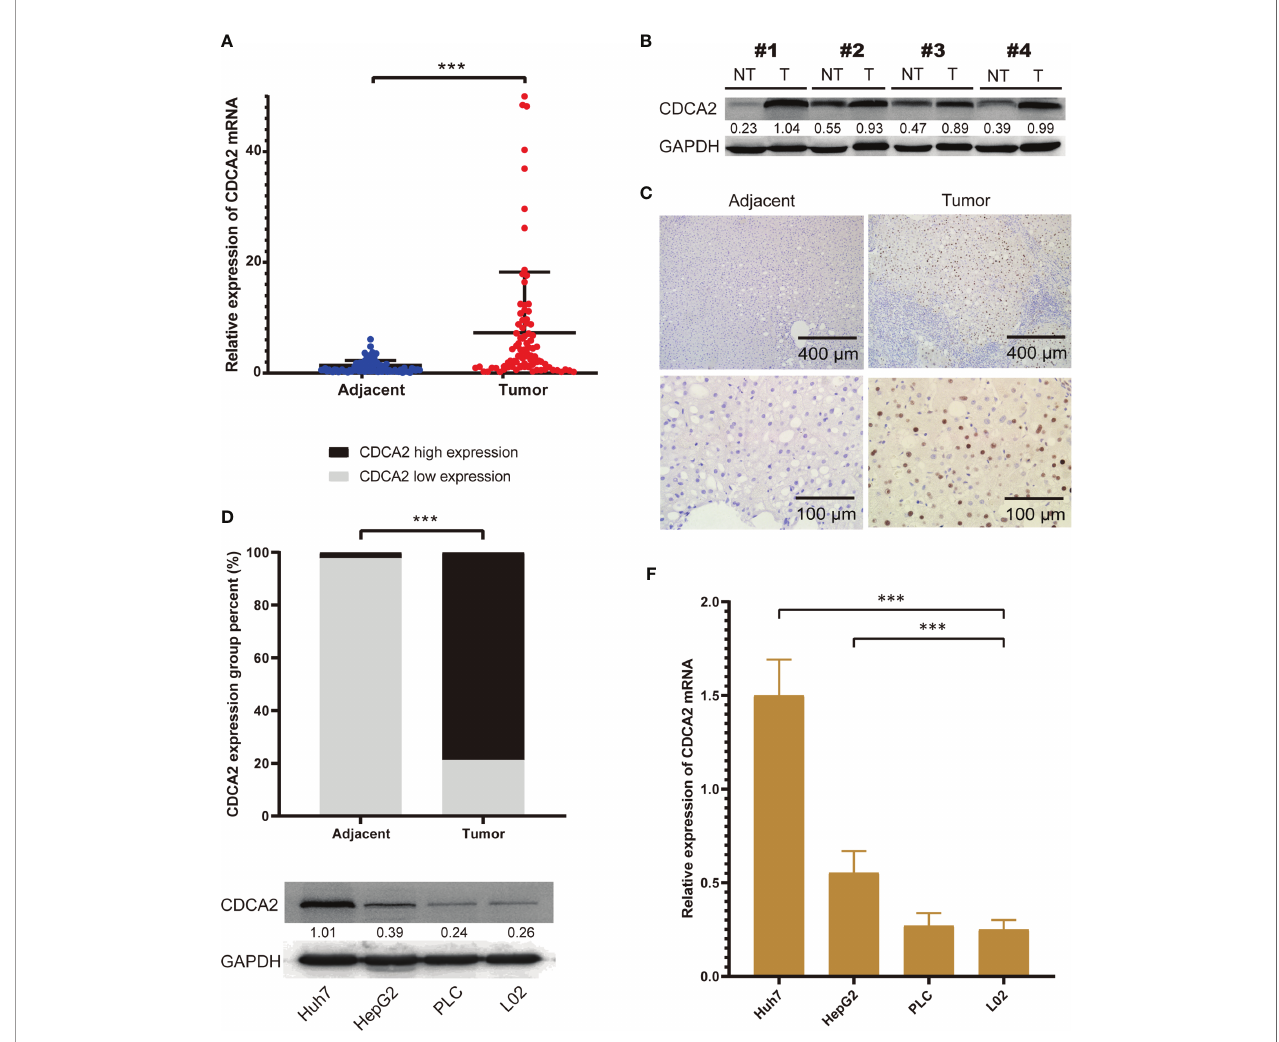
FIGURE 4 | The expression of cell division cycle associated 2 (CDCA2) in hepatocellular carcinoma (HCC) tissues and cells. (A) The mRNA levels of CDCA2 in hepatocellular carcinoma (HCC) and paraneoplastic tissues in patients. (B) Protein levels of CDCA2 in four pairs of HCC and paraneoplastic tissues; quantitative analysis was performed with ImageJ software. (C) Immunohistochemistry (IHC) staining showed that CDCA2 was expressed in the nucleus of HCC cells. (D) Morphological analysis showed a positive average rate of 78.8% for CDCA2 in HCC and 2.3% in paraneoplastic tissues. (E) Protein levels of CDCA2 in Huh7, HepG, PLC, and L02 cells; quantitative analysis was performed with ImageJ software. (F) The mRNA levels of CDCA2 in four cells. ***p <